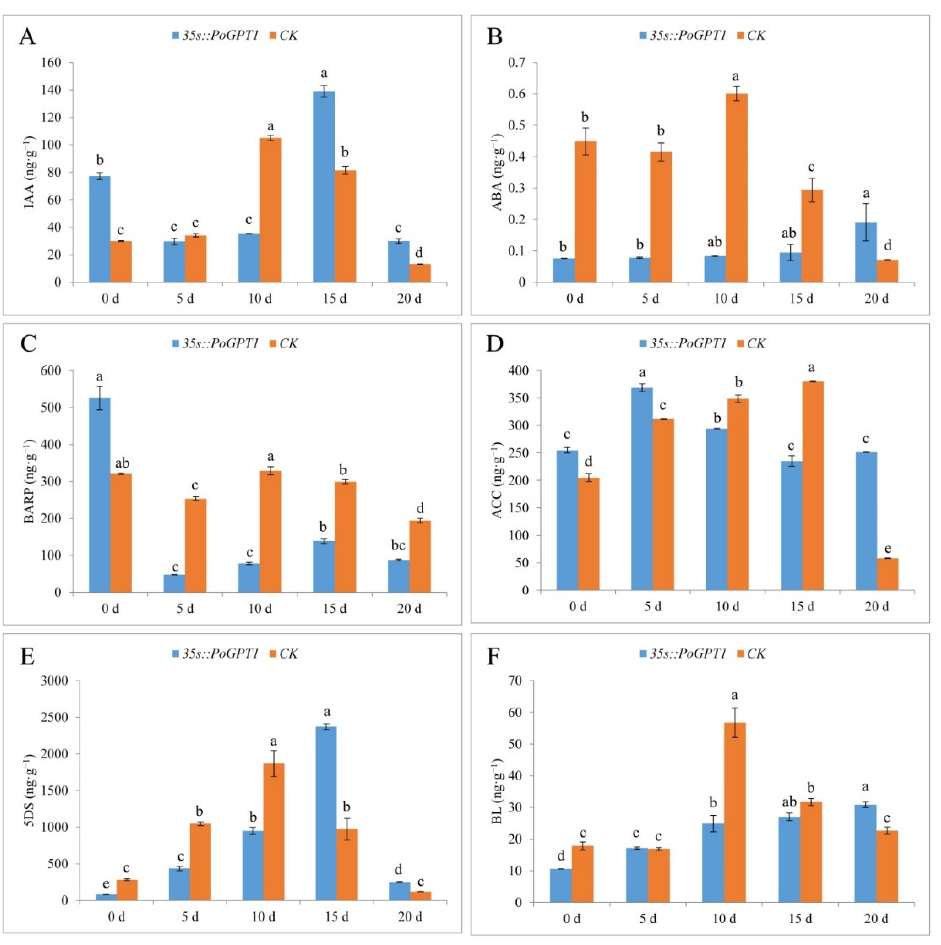
Figure 7. Endogenous plant hormone contents in tree peony calli (( A ), IAA; ( B ), ABA; ( C ), BARP; ( D ), ACC; ( E ), 5DS; ( F ), BL). Vertical bars indicate standard error ( n = 3). Different letters indicate significant differences using the Duncan’s Multiple Range Test ( p ≤ 0.05).